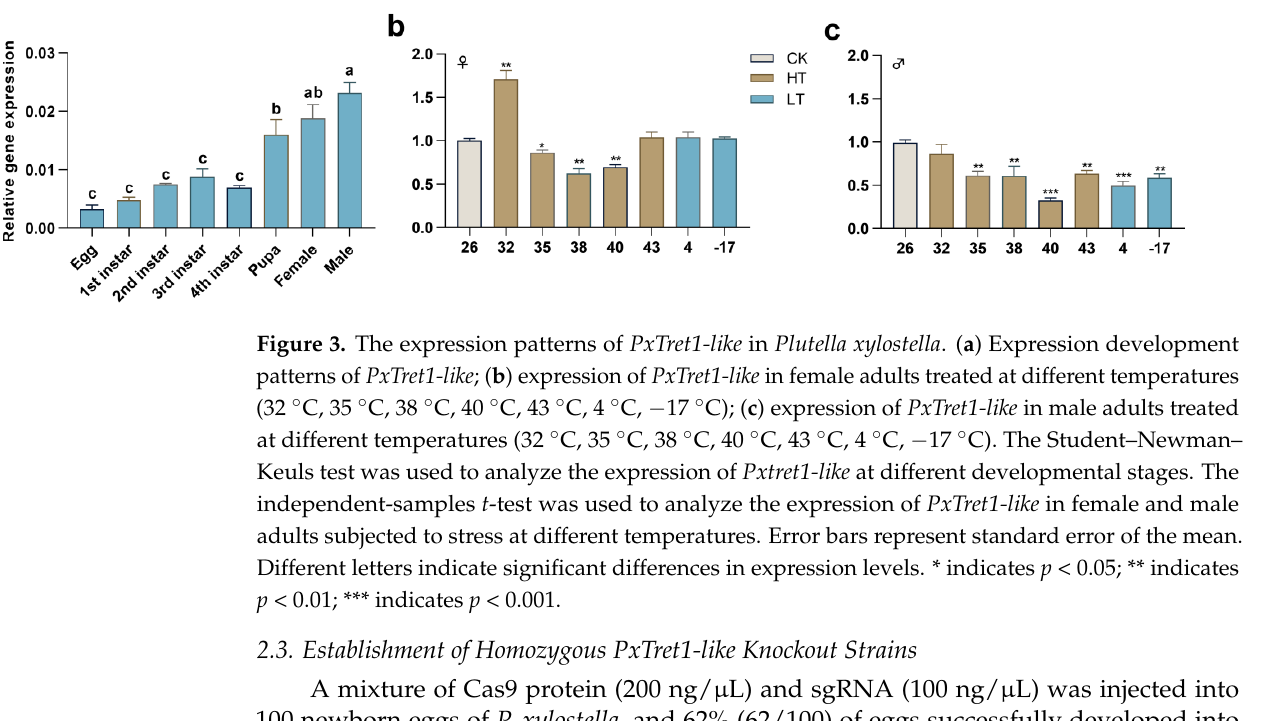
cantly decreased at 35 °C, 38 °C and 40 °C. In the male, the expression level of PxTret1-like